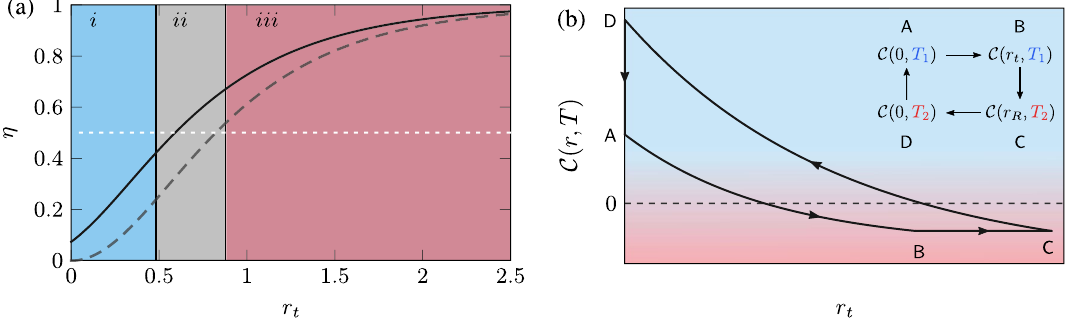
Figure 4. ( a ) The thermodynamic efficiency of the generalised cycle (black curve), Otto cycle (dashed grey) curve and the Carnot efficiency (dashed white) as a function of the squeezing parameter for T 1 = (cid:31) ω/ k B and T 2 = 2 (cid:31) ω/ k B . Also illustrated, a phase diagram with the three regimes of the cycle (i, ii, and iii) . The three different colours denote the degree of non-classicality of the bosonic mode. While blue and red indicate the classical, and non-classical behaviour of the mode, the grey colour represents that the mode is non-classical for T 1 , but classical for T 2 . In ( b ) the Classicality function (10) over the generalised cycle as a function of the squeezing parameter for T 1 and T 2 . The blue and red-shaded denotes the classical, and non-classical regime,